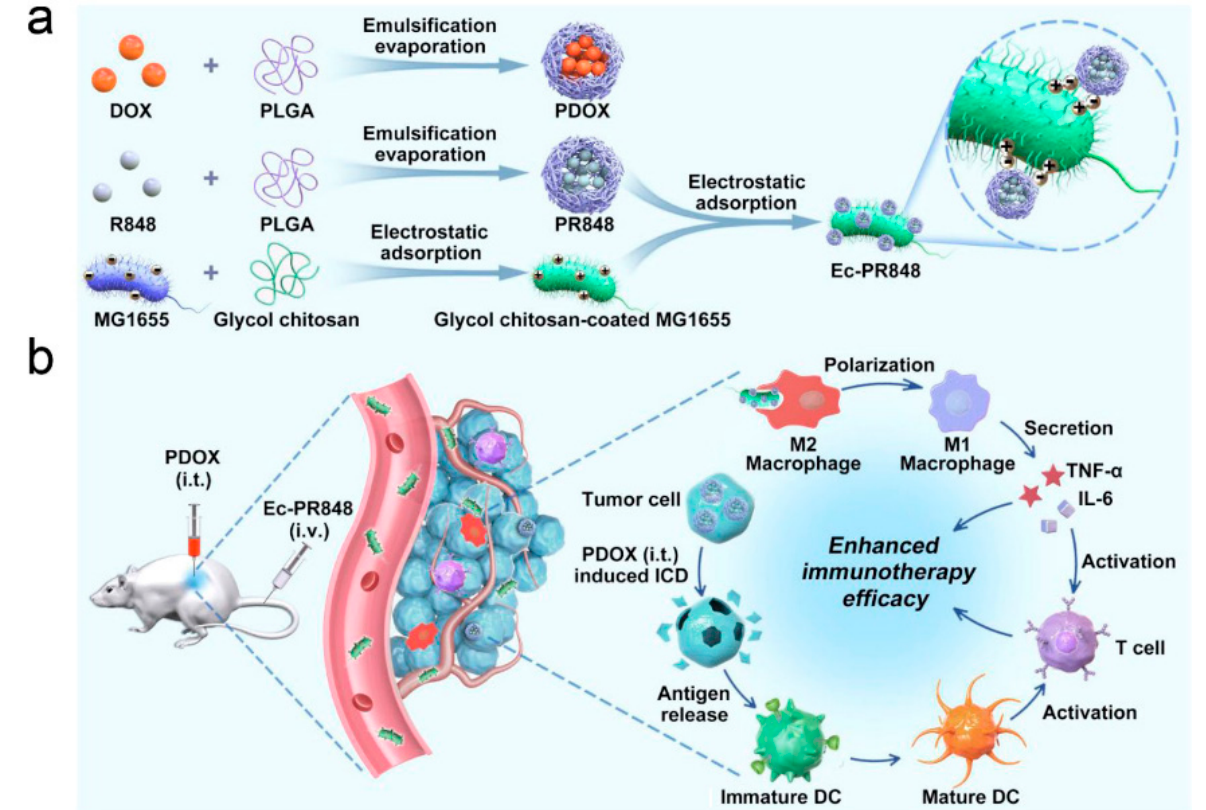
Figure 4. Scheme for ( a ) the preparation of resiquimod-loaded PLGA– E. coli (Ec-PR848) in combi- nation with PDOX; ( b ) PDOX-induced ICD enhances the immunotherapeutic effect derived from TAM polarization. Repoduced with permission from Ref. [118], Nano Letters, 2021. Copyright© 2021, American Chemical Society.